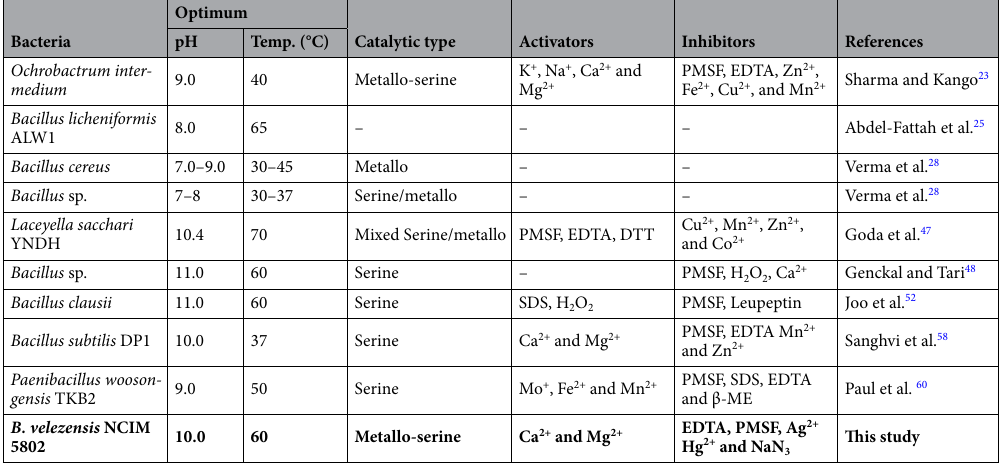
Table 3. Comparative account of characteristics of bacterial keratinases. Significant values are given in bold.